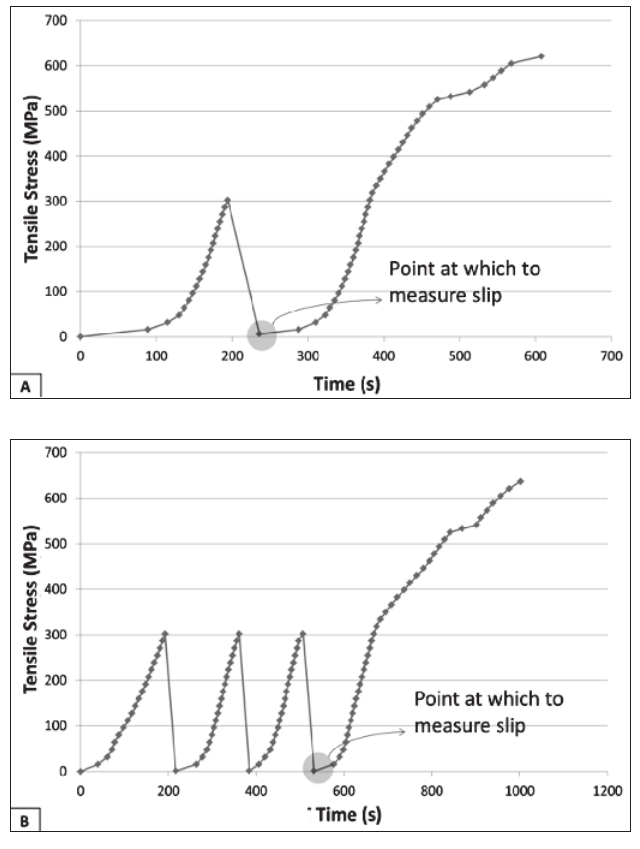
Transducers in groups of three installed on the fixed triangular steel bases used in test method 3